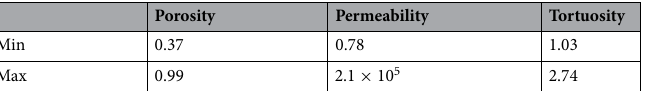
not contain the information. Hence in the training and inference process, the picture without margins is taken 400 . as an input for the network. Effectively, the input has the size 400 × 400 nodes, which are either free or blocked for the fluid flow. The periodic Each figure consists of 400 × boundary condition is set at sides with margins, whereas two remaining sides are considered no-slip boundary 4 condition. To generate the medium at given porosity, we start with an empty system and systematically add 4 × quad obstacles at random positions in the porous region. The margins are excluded from this deposition proce- dure. We do not consider blocking of sites, thus, obstacles may overlap freely. Each time an obstacle is placed, we update current porosity and stop, if the desired value is reached. In the next step of the generation of figures, we